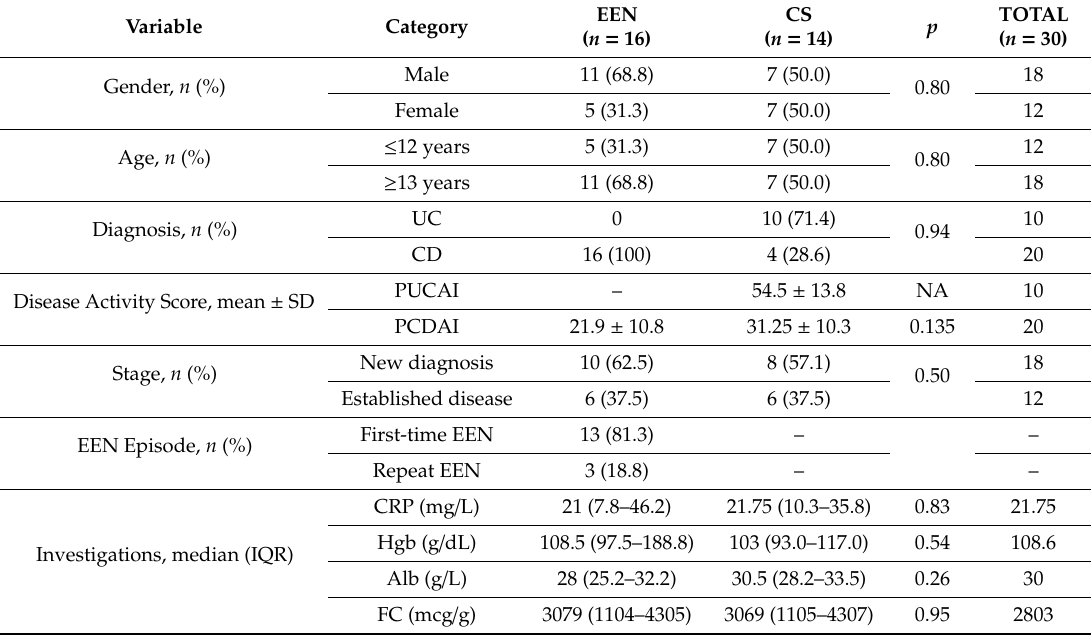
Table 1. Baseline characteristics of patients starting induction therapy with EEN or CS.